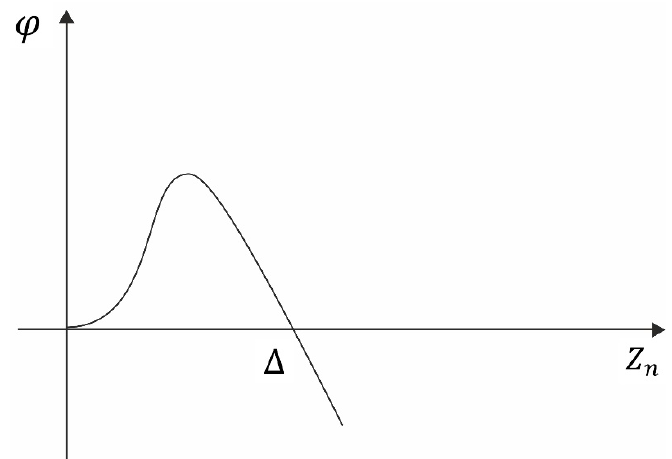
Figure 2. The rate of change in the number of nodes (second technology).